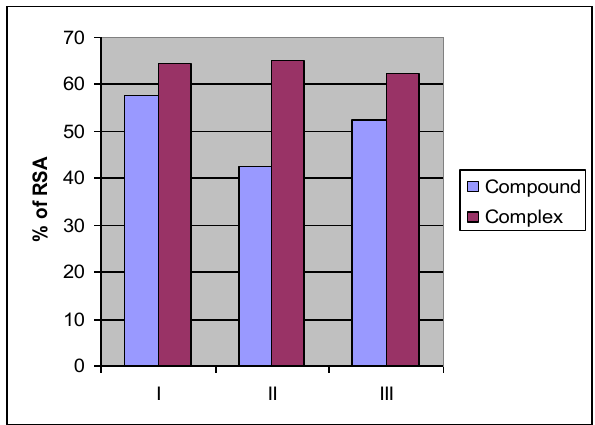
Figure 5: Anti-Oxidant activity of Compound I, II and